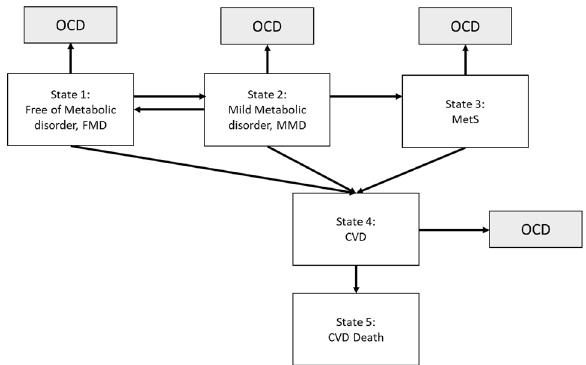
Figure 2. Six-state continuous-time Markov